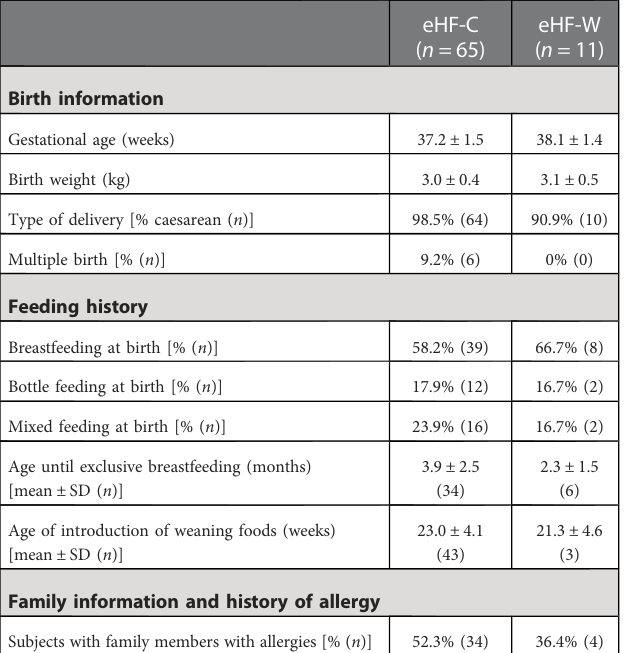
TABLE 3 Demographic characteristics of the study subjects in both groups: eHF-C ( n = 65) and eHF-W ( n = 11).